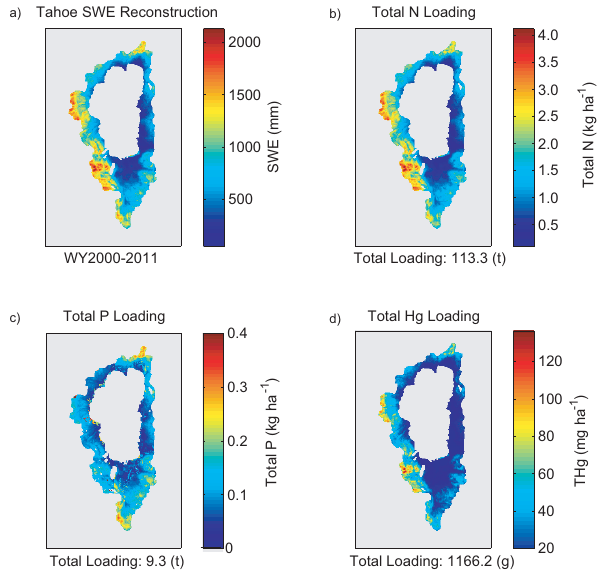
Figure 2. (a) Decadal average (2000–2011) peak SWE for the Tahoe Basin from SWE reconstruction for the Sierra Nevada, and basin-wide peak snowpack chemical loading estimates for (b) ni- trogen, (c) total phosphorus, and (d) total